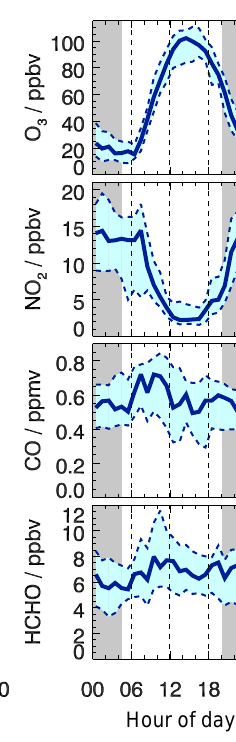
Figure 6. Hourly median diurnal profiles of measured j (O 1 D), O 3 , NO, NO 2 , HONO, CO, isoprene (ISO) and HCHO (thick lines give median values, colored areas give the 25 and 75% percentiles). Grey areas indicate